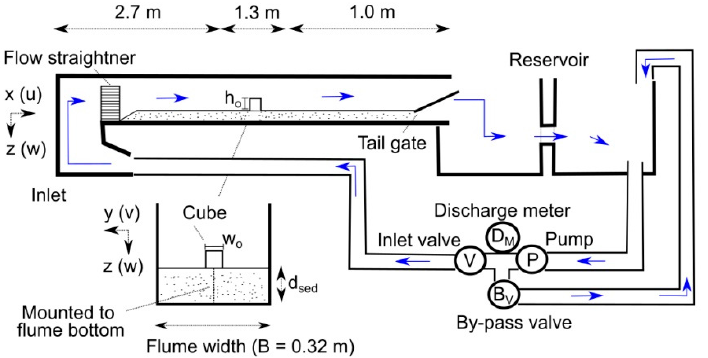
Figure 4. Sketch of the flume with discharge-controlling system (arrows indicate direction of flow).